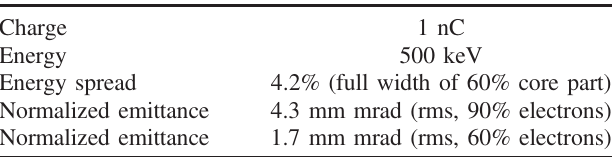
TABLE III. Measured beam parameters at the exit of the electron gun